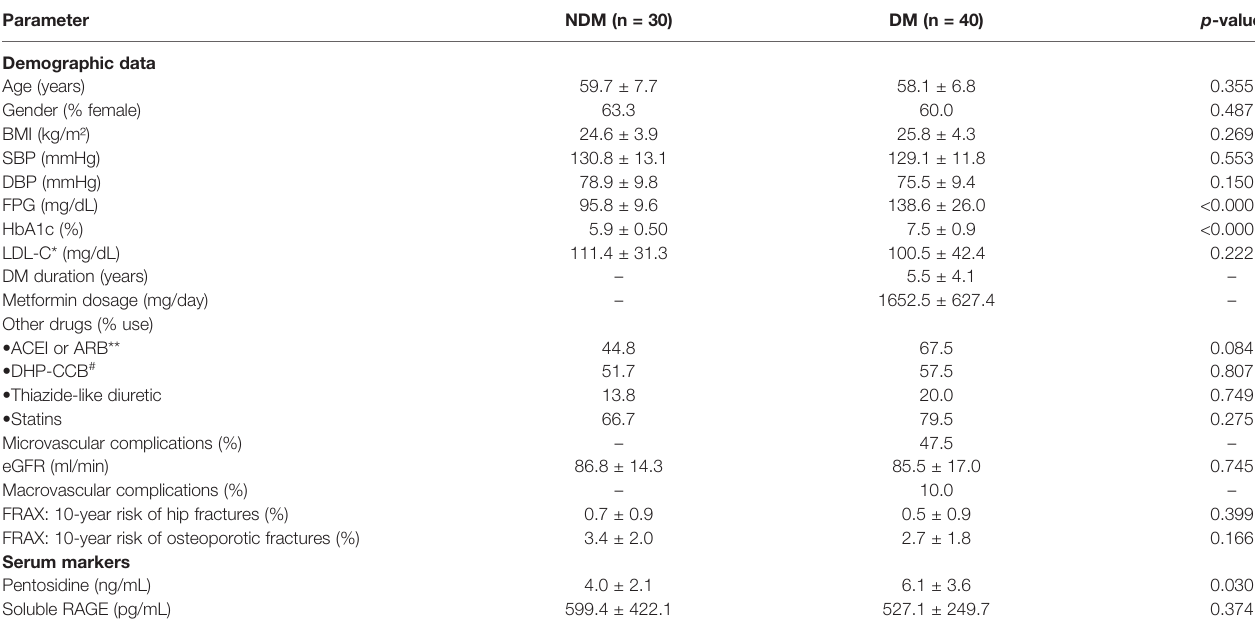
TABLE 2 | Clinical characteristics of the study